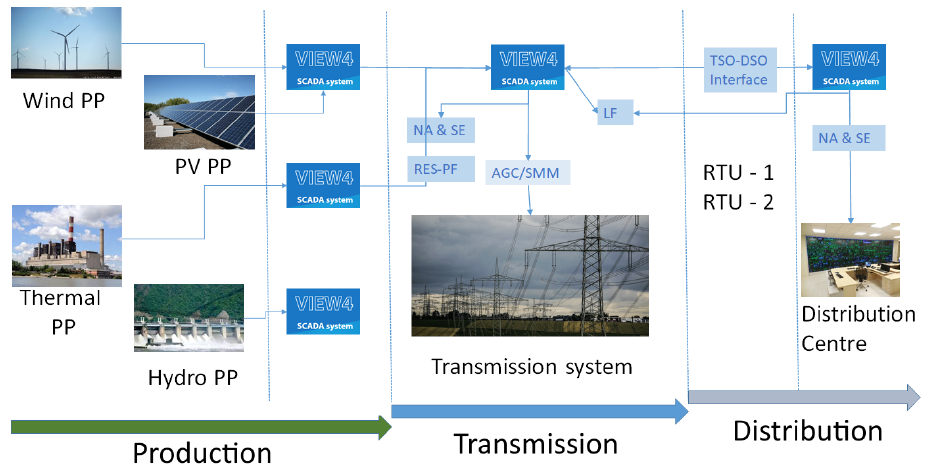
Figure 1. The electricity value